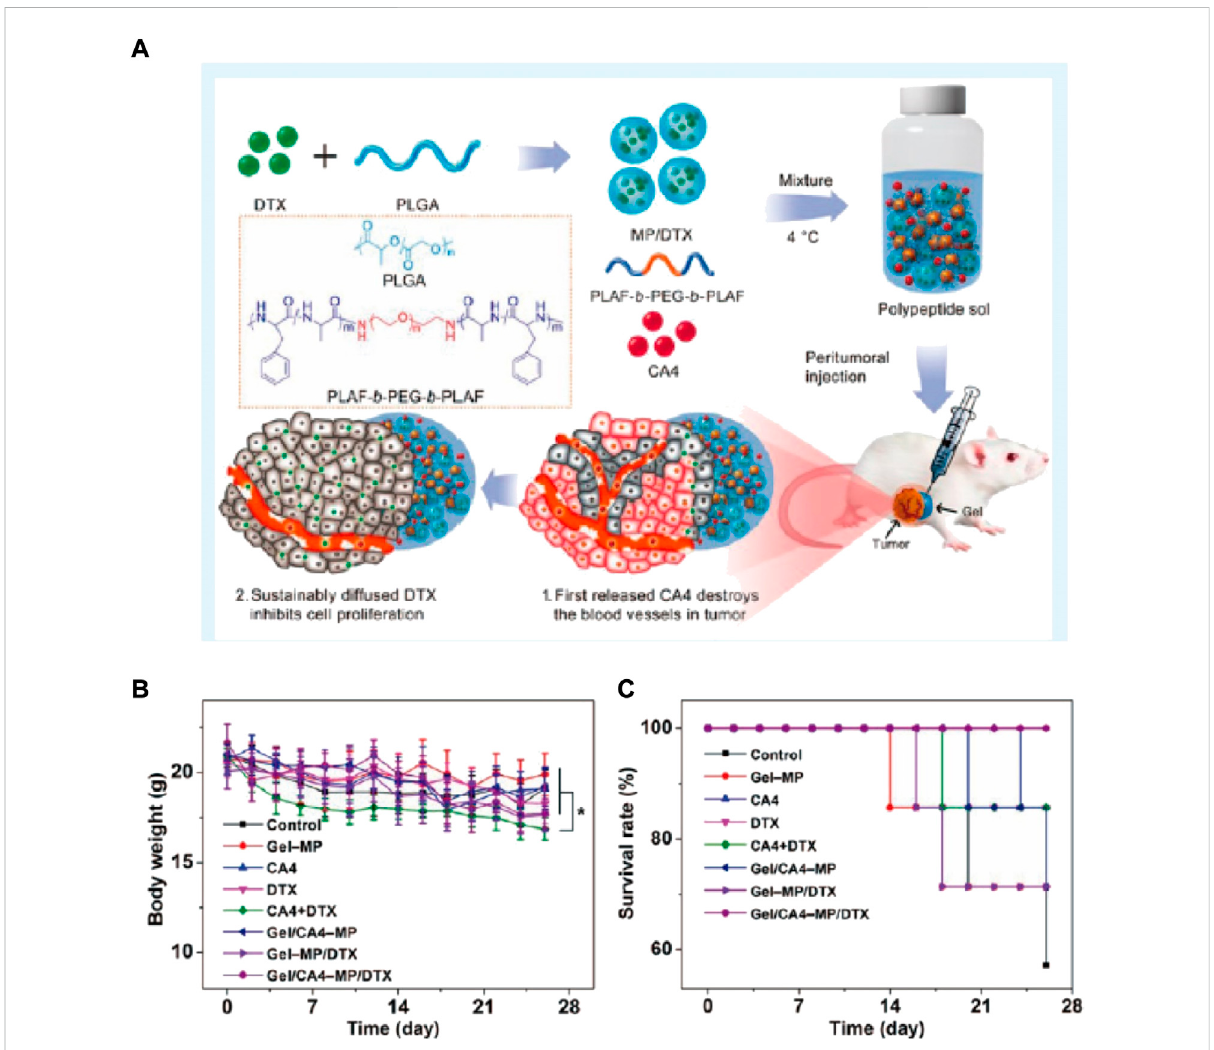
FIGURE 1 (A) Sequential Drug Delivery with Gel-MP Construct, Showing Preparation of Gel/CA4 − MP/DTX for Two-Pronged Locally Synergistic ChemotherapyofOsteosarcoma. (B) Variationsofbodyweightandsurvivalrate. (A) Changeofbodyweightand (B) survivalrateofK7osteosarcoma- grafted mice after treatment of PBS as control, Gel − MP, CA4, DTX, CA4+DTX, Gel/CA4 − MP, Gel − MP/DTX, or Gel/CA4 − MP/DTX. [Data were represented as mean ± SD ( n = 10; (*) p <